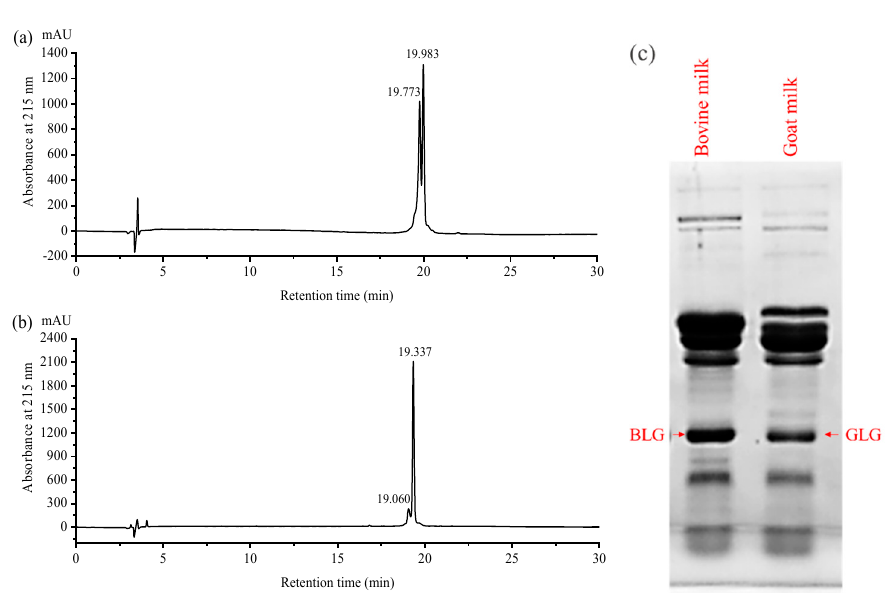
Figure 1. Reversed Phase High Performance Liquid Chromatography (RP-HPLC) chromatogram of bovine milk β -lactoglobulins ( a ) and goat milk β -lactoglobulins ( b ), and Sodium Dodecyl Sulfate Polyacrylamide Gel Electrophoresis (SDS-PAGE) of bovine and goat milk ( c ). Bands of bovine and goat milk β -lactoglobulins in SDS-PAGE pattern named Bovine milk β -Lactoglobulin (BLG) and goat milk β -Lactoglobulin (GLG), respectively.